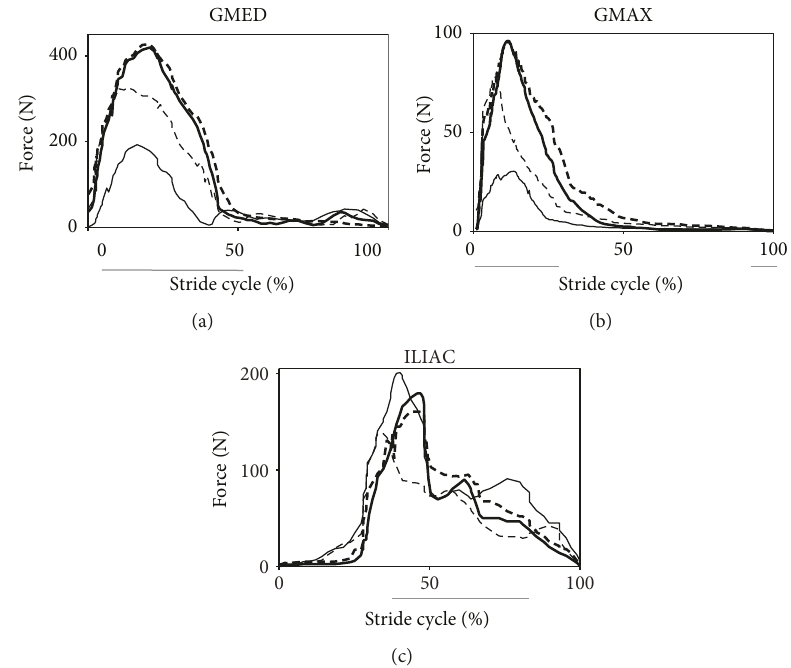
Figure 1: Comparison of the muscle forces computed from static optimization for pre- and postoperative periods (a) GMED, (b) GMAX, and (c) ILIAC muscles. The horizontal solid bars indicate the periods of experimental EMG activity obtained from the literature [28, 29]. Solid bold line: pre-op; solid thin line: post-op1; thin dashed line: post-op2; bold dashed line: